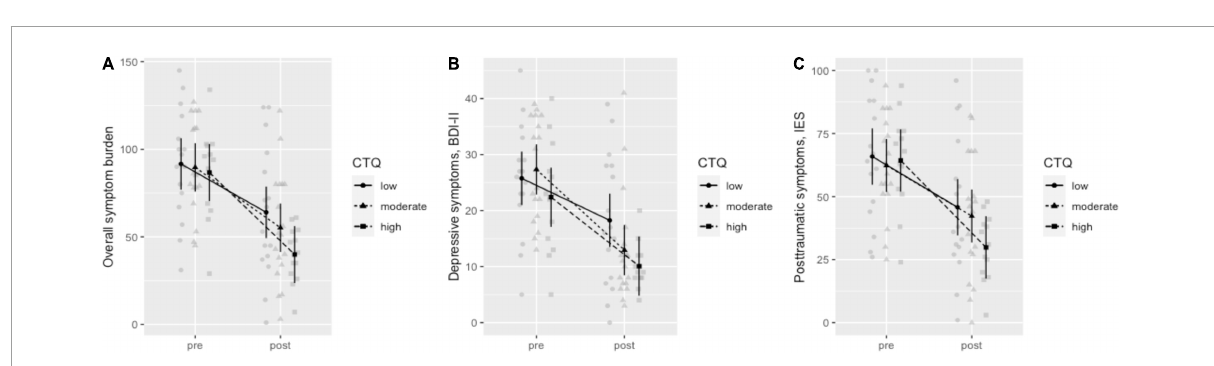
FIGURE4 Influence of childhood maltreatment on therapy outcome. (A) Overall symptom burden, (B) depressive symptoms BDI-II, (C) posttraumatic symptoms